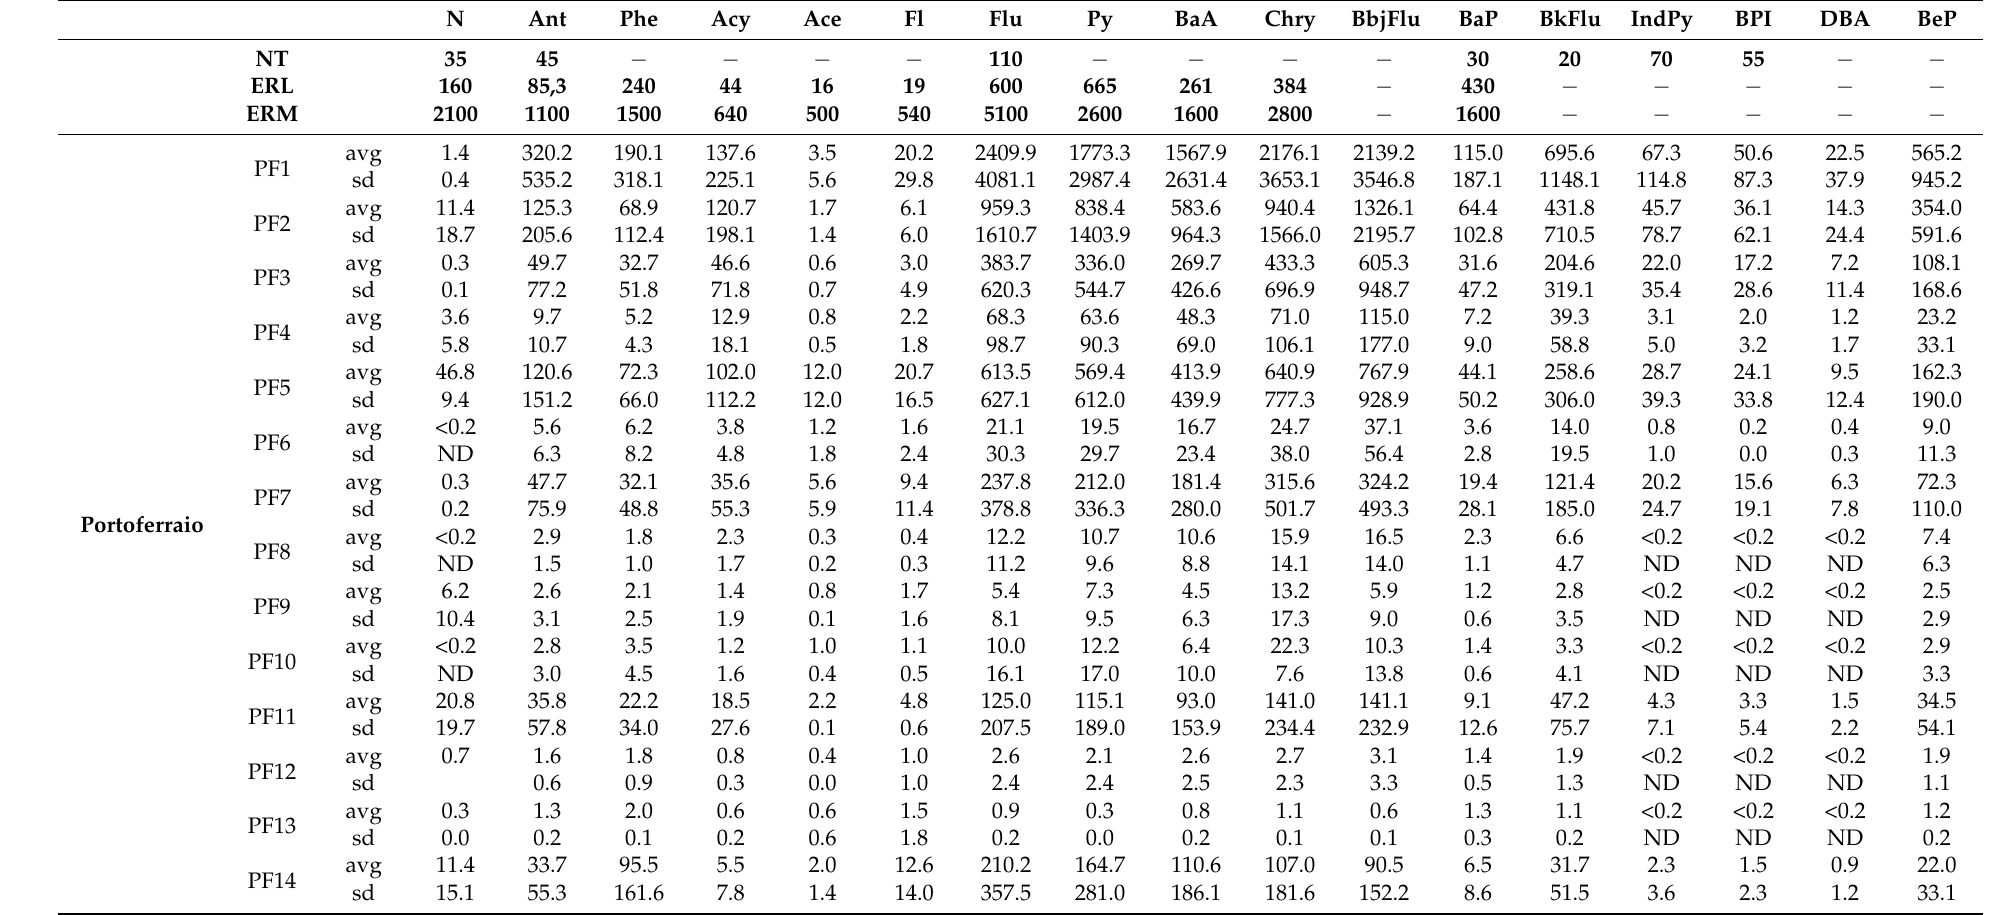
Table A2. Concentrations of PAH (Units: µ g/kg d.w.). National Thresholds (NT, According to DL56/2009), ERL and ERM (according to Long et al., 1995) are also reported. Naphthalene (N), Anthracene (Ant), Phenanthrene (Phe), Acenaphthylene (Acy), Acenaphthene (Ace), Fluorene (Fl), Fluoranthene (Flu), Pyrene (Py).Benz[a]anthracene (BaA), Chrysene